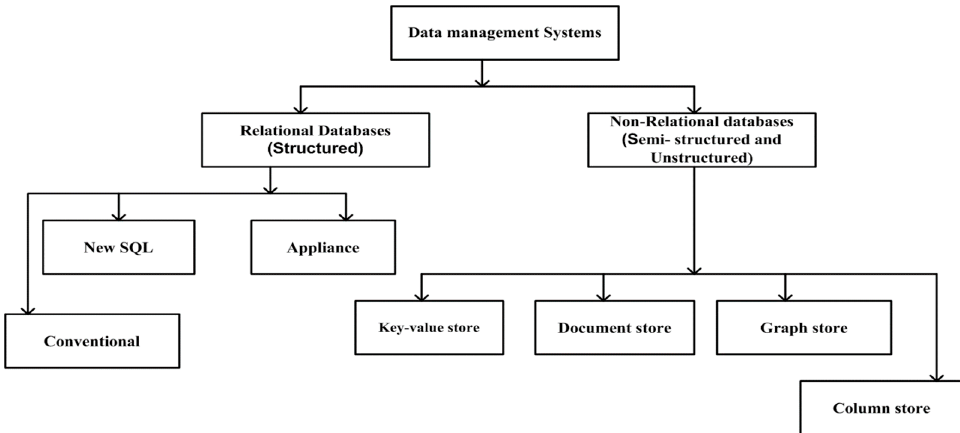
Figure 1. Data collection and storage.